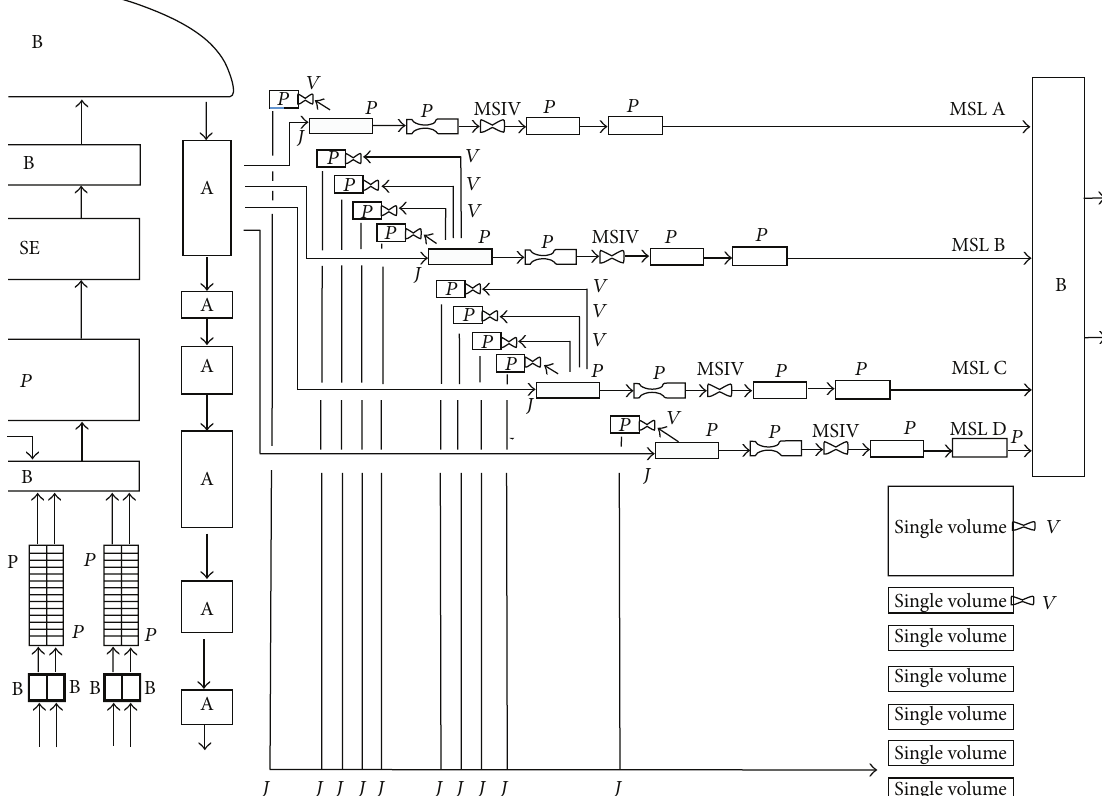
Figure 2: Schematic of connections from RPV to PSP, passing through the SRVs.